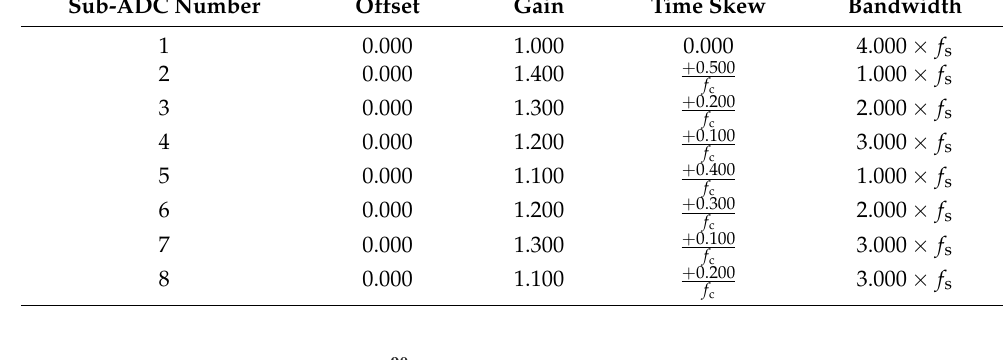
Table 3. The mismatches of the TI ‐ ADCs system.